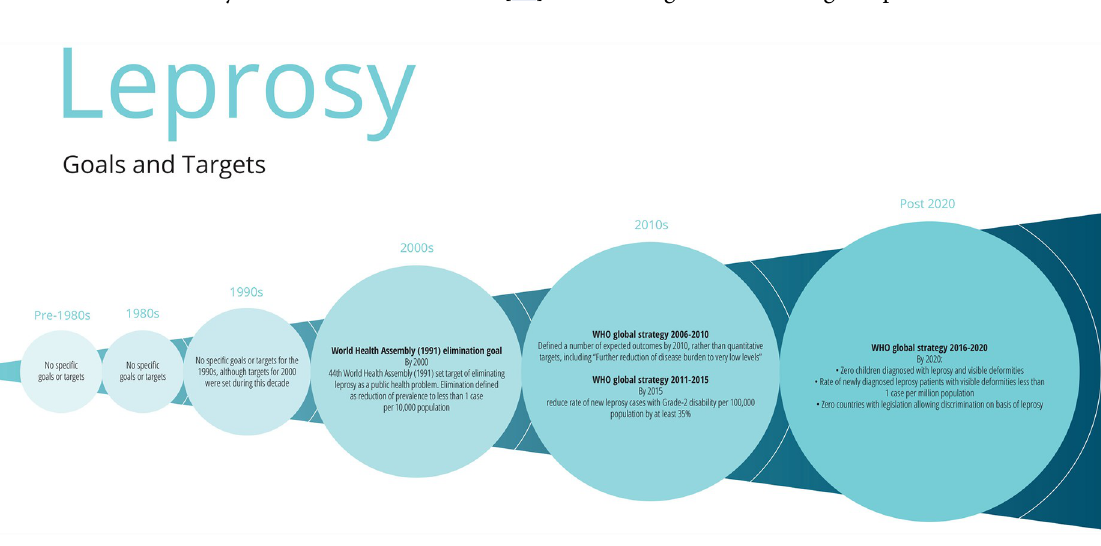
Fig 2. Major goals and targets for